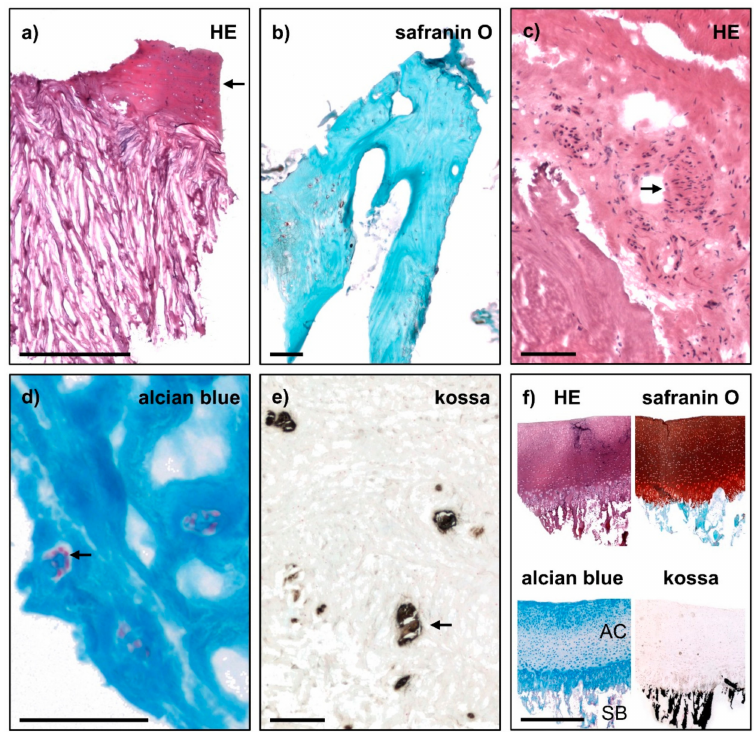
Figure 2. Histology of exemplary samples that showed ( a – c ) impurities and ( d – e ) severe signs of degeneration on cellular level according to IVD and DD scoring. ( a ) Cartilage endplate, ( b ) bone, ( c ) unusual cell accumulation, ( d ) clustered cells and ( e ) calcium deposits (all indicated by arrow). ( f ) Staining controls of porcine articular cartilage (AC) with adjacent subchondral bone (SB) for ( a , c ) haematoxylin-eosin (HE) staining, ( b ) safranin O staining (cartilage in red, bone in cyan), ( d ) alcian blue staining (cell nuclei in pink, proteoglycans in blue) and ( e ) von Kossa staining (calcification and SB in black, cell nuclei in pink). Scale bar in ( a , f ) 1 mm and in ( b – e ) 0.1